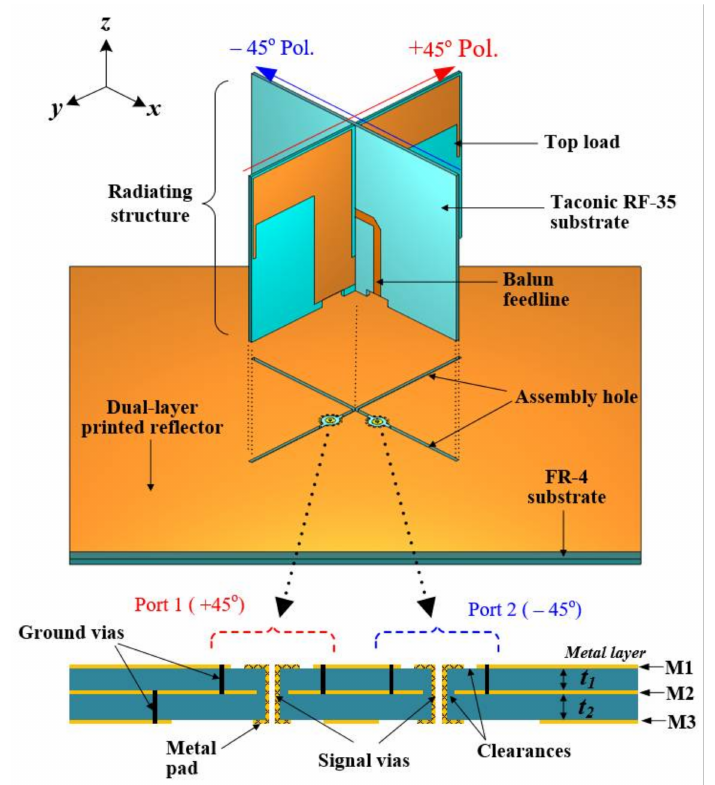
Figure 1. Configuration of the proposed antenna with printed dual-layer